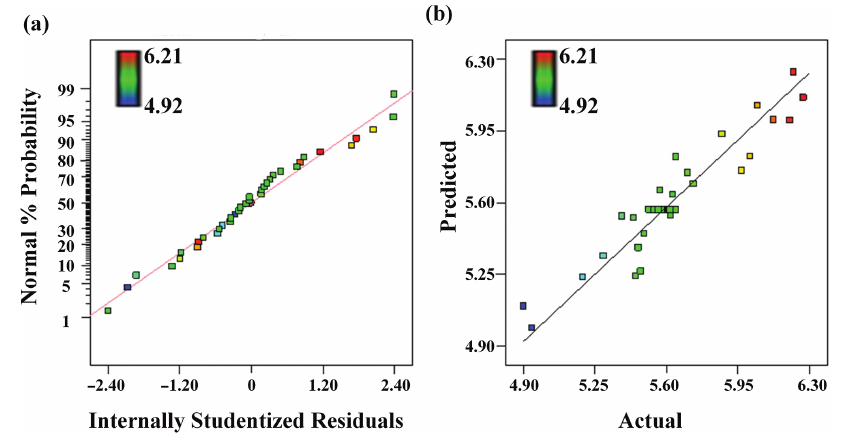
Figure 6: Quadratic model: (a) normal probability plot of the residuals and (b) plot of actual versus predicted weld bowing